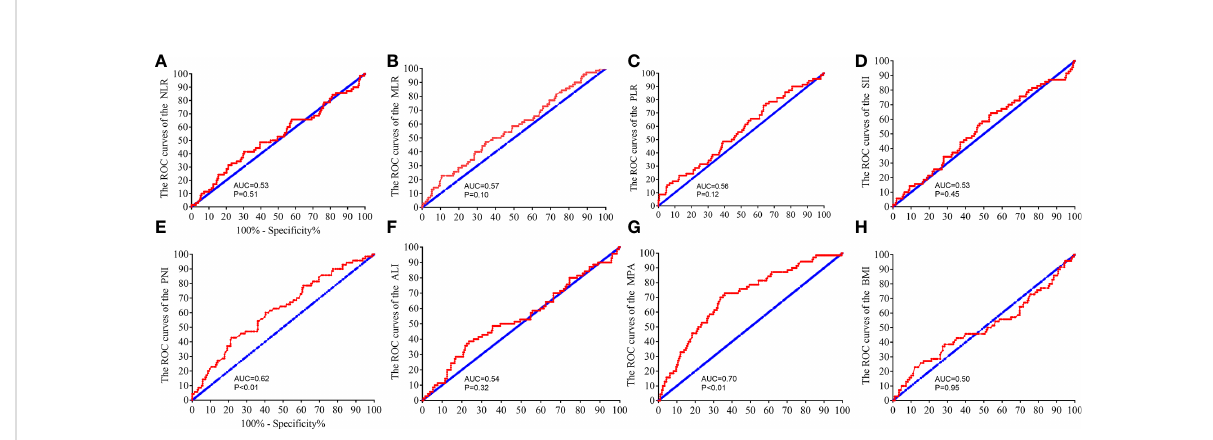
FIGURE 5 Receiver operating characteristic (ROC) analysis to evaluate the predictive ef fi ciency of the NLR, SII, PLR, MLR, PNI, ALI, MPA, and BMI level in patients with LARC for NCRT response. The ROC analysis for NLR (A) , MLR (B) , PLR (C) , SII (D) , PNI (E) , ALI (F) , MPA (G) , and BMI level (H)